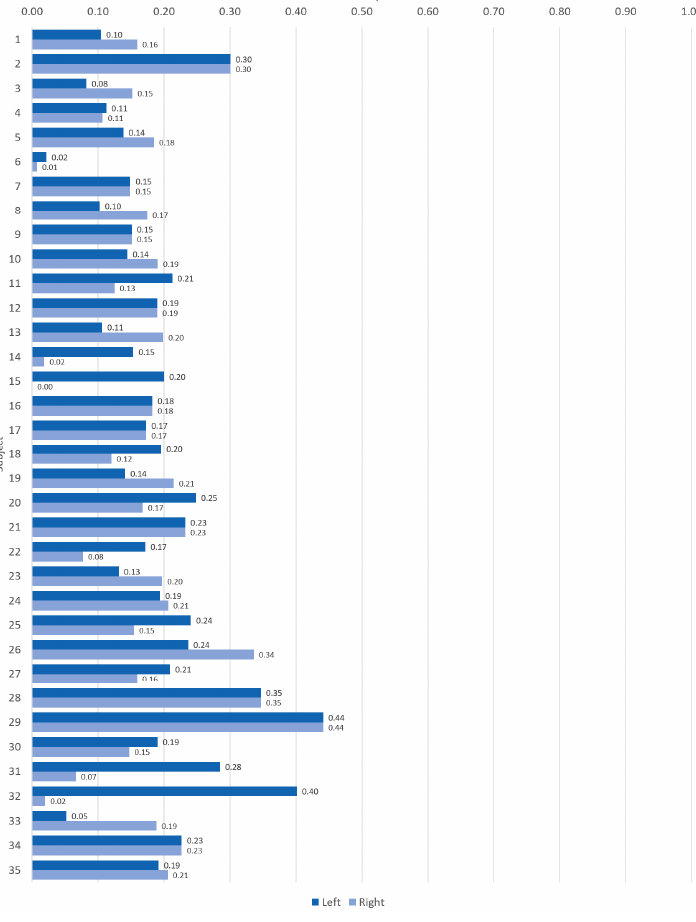
Figure 10. Efficacy for each